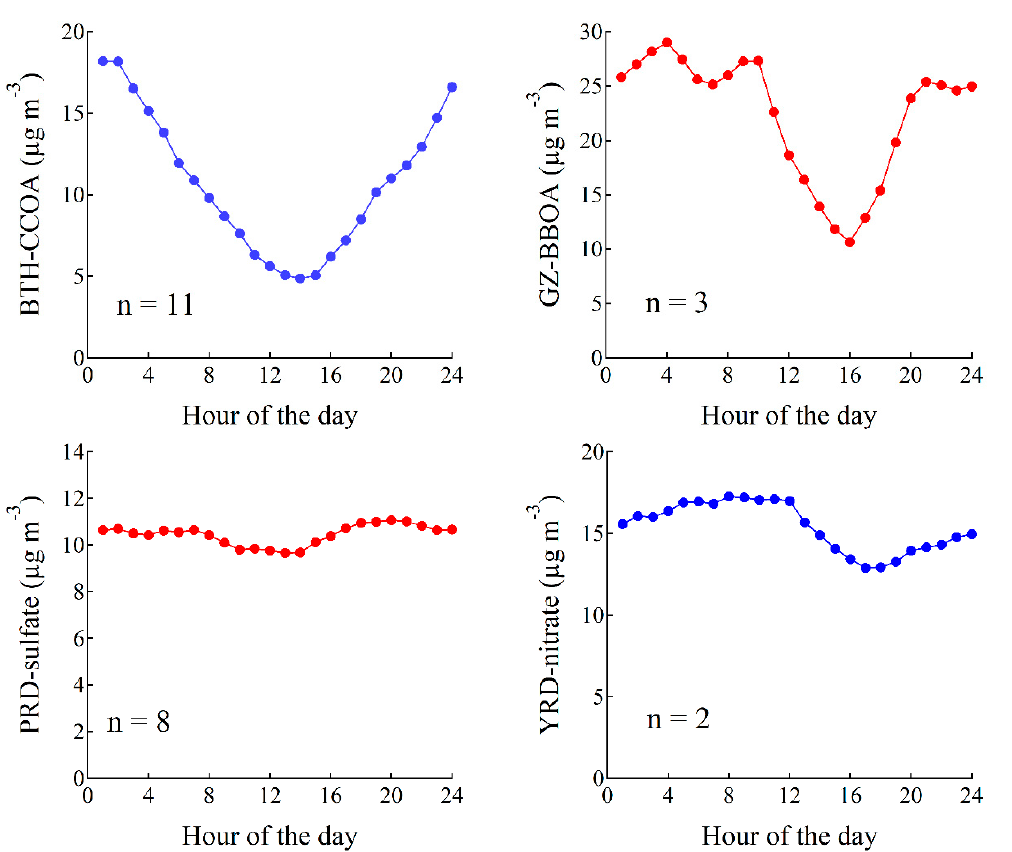
Figure 7. Average diurnal variations of BTH-CCOA, GZ-BBOA, PRD-sulfate, and YRD-nitrate in the four regions. n represents the number of data points used in the diurnal variation plots.